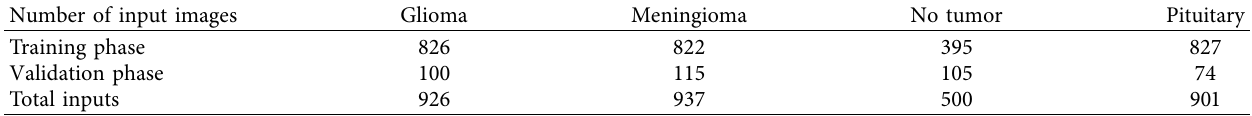
Table 1: Input matrix for the proposed HDL2B-TUMOR-CLASSIFIER.